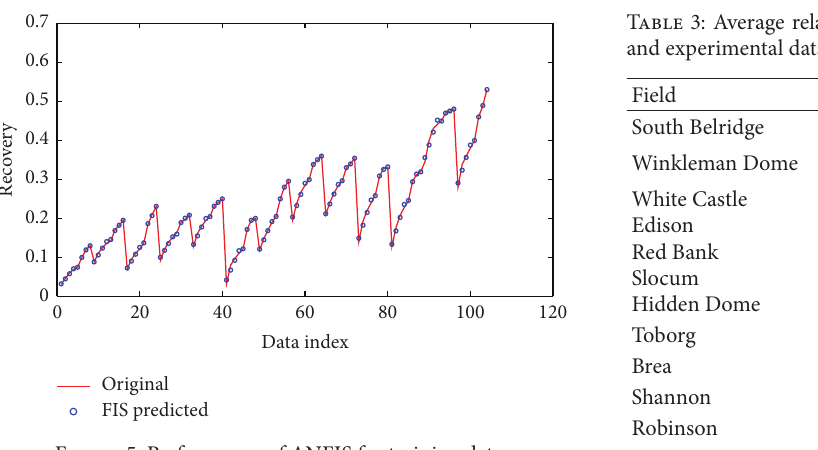
Figure 5: Performance of ANFIS for training data.